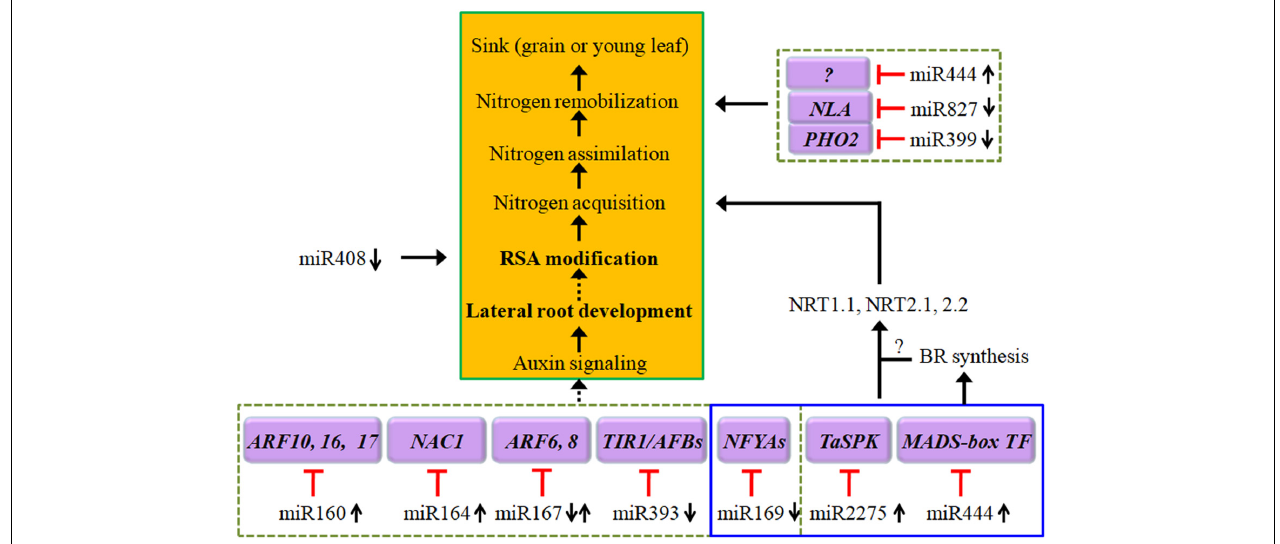
FIGURE 2 | Diagram of low-N stress-induced alteration in the expression of a set of miRNAs that in turn regulate the expression of their targeted genes and then construct several regulatory pathways, including auxin signaling for root architecture modifications, expression of NRTs for N uptake and transport, and expression of NLA (nitrogen limitation adaptation) and PHO2 for N remobilization. The black arrows indicate positive signaling steps, the red lines with short vertical columns indicate negative signaling steps, and the dashed lines with solid arrowheads indicate putative regulation. See the text for further explanation. NFYA, nuclear factor Y, subunit